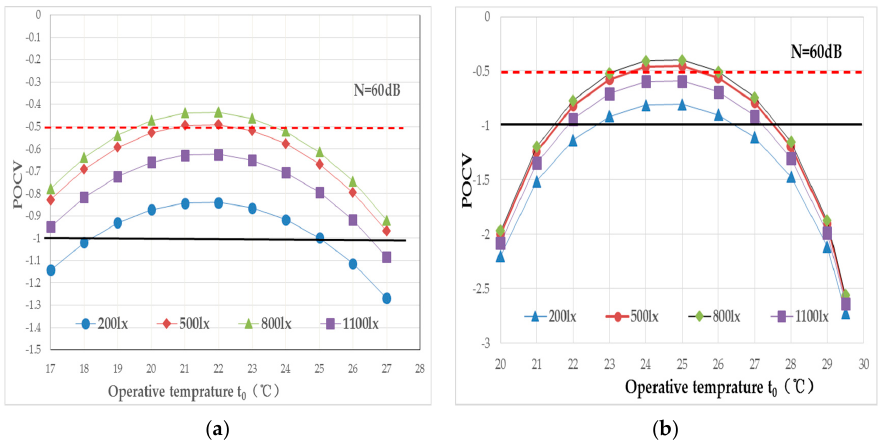
Figure 12. The corresponding predicted overall comfort vote (POCV) value of noise and illumination at different temperature: ( a ) Winter; ( b ) Summer.